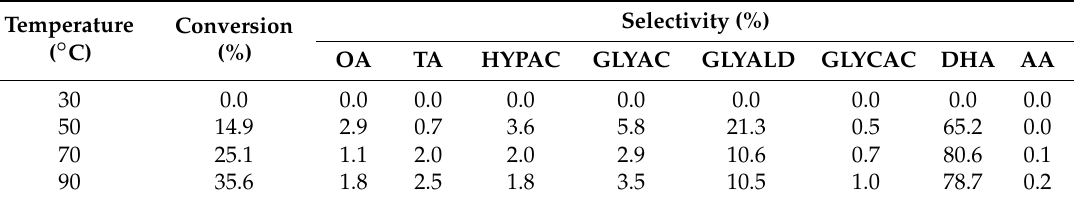
Table 2. Catalytic reaction results on Pt–Bi/HT catalysts at various reaction temperatures a .